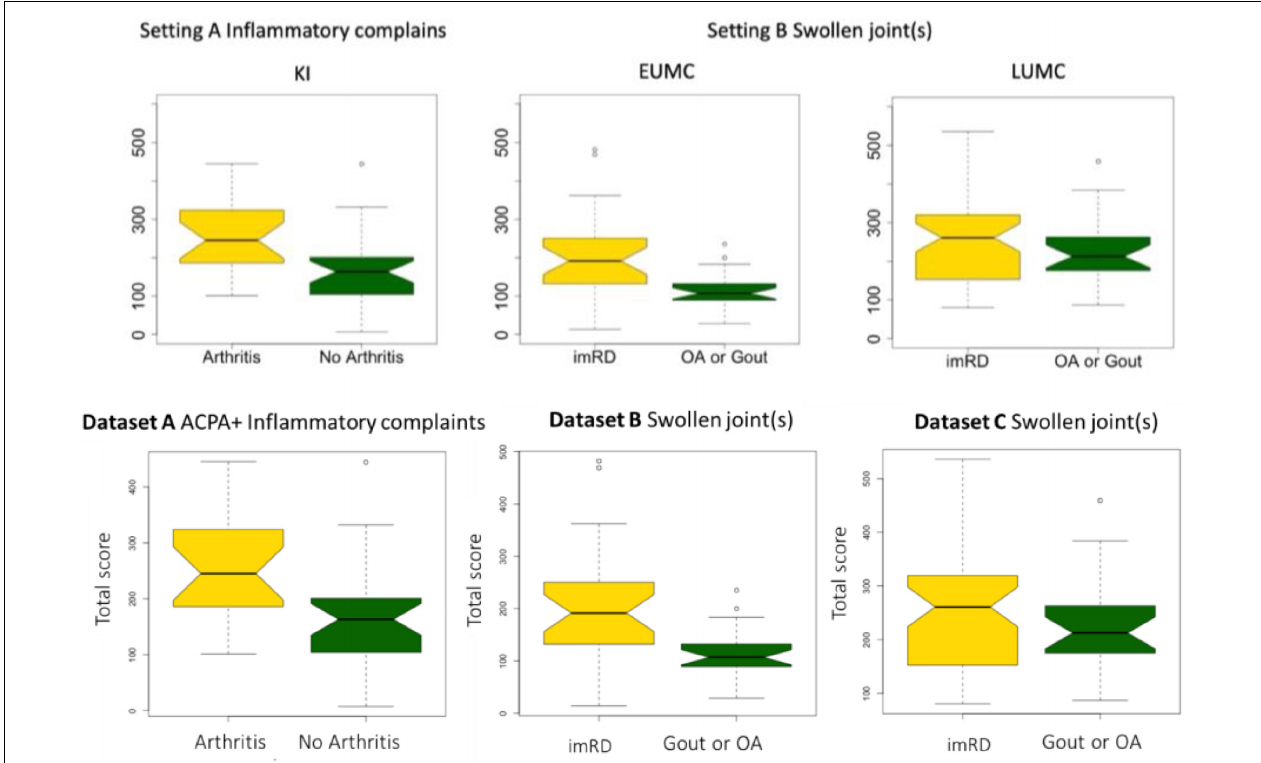
FIGURE 1 | Total score in each dataset. Boxplot depicting the differences in total score between those who developed arthritis (dataset A) or an immune-mediated rheumatic disease (imRD) (datasets B and C) and those who did